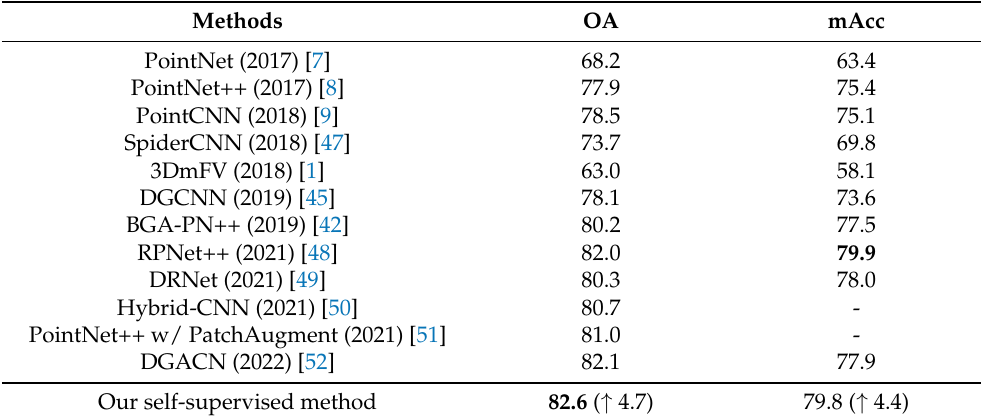
Table 2. Classification accuracy on ScanObjectNN. ↑ represents the improvement compared to the baseline.